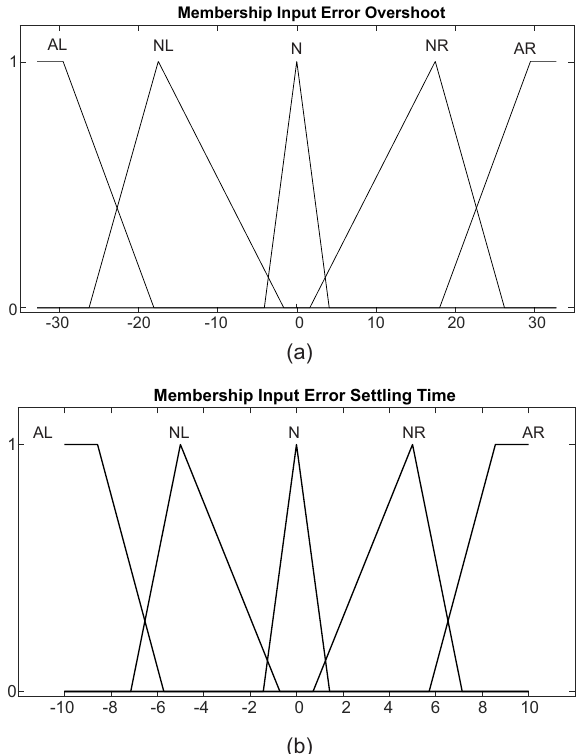
Figure 4. Inputs of 5 × 5 MFs designed in MATLAB/SIMULINK. ( a ) Error MF overshoot and ( b ) error MF settling time.